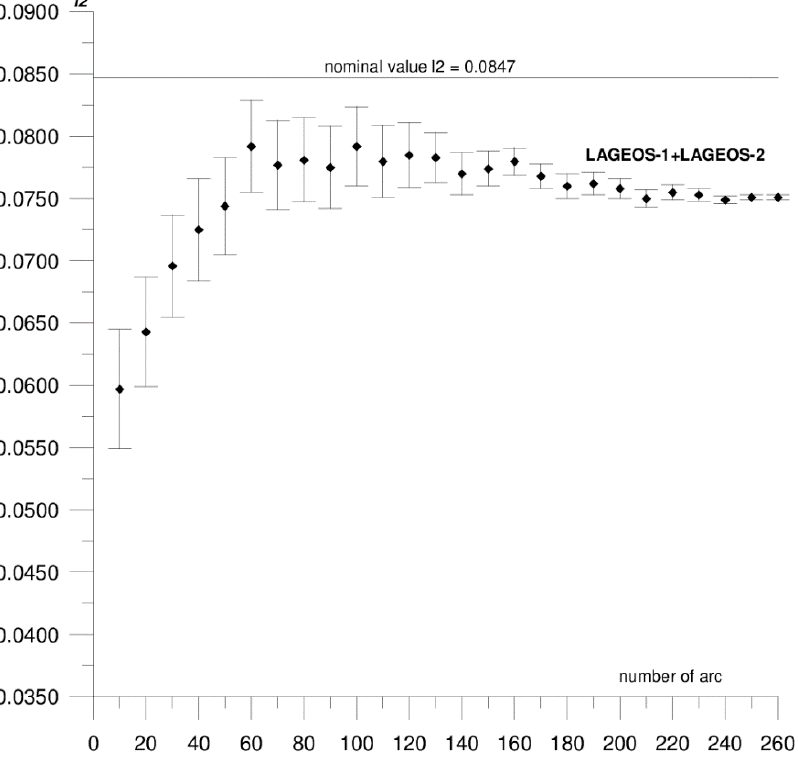
Sensors 2020 , 20 , 6851 Figure3. SequentialsolutionfortheYarragadeelocal h 2 parameterbasedonSTELLA + STARLETTE data. Figure 3. Sequential solution for the Yarragadee local h 2 parameter based on STELLA+STARLETTE data.